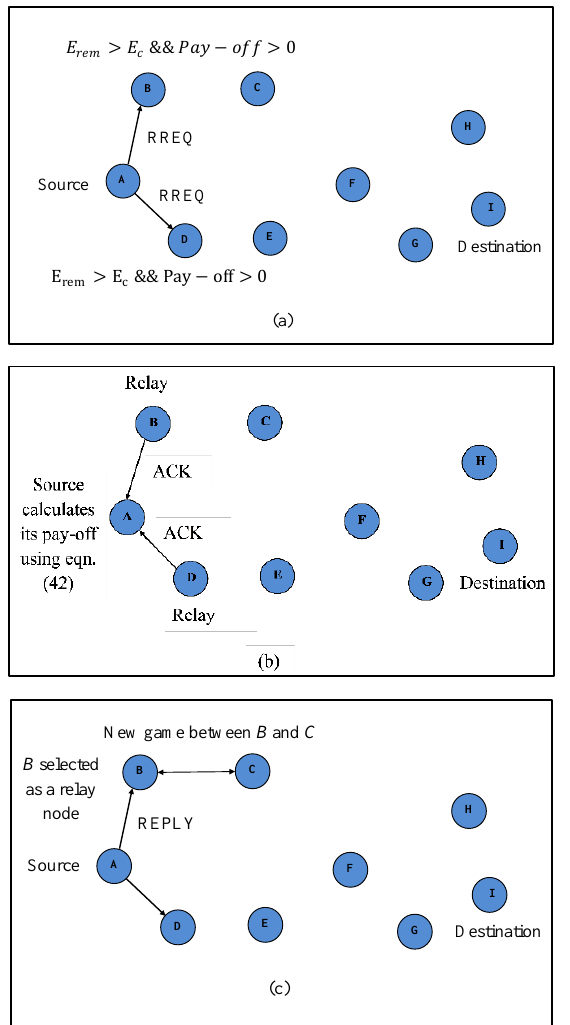
Figure 7. Network scenario where the neighboring node knows the optimal route to the destination.